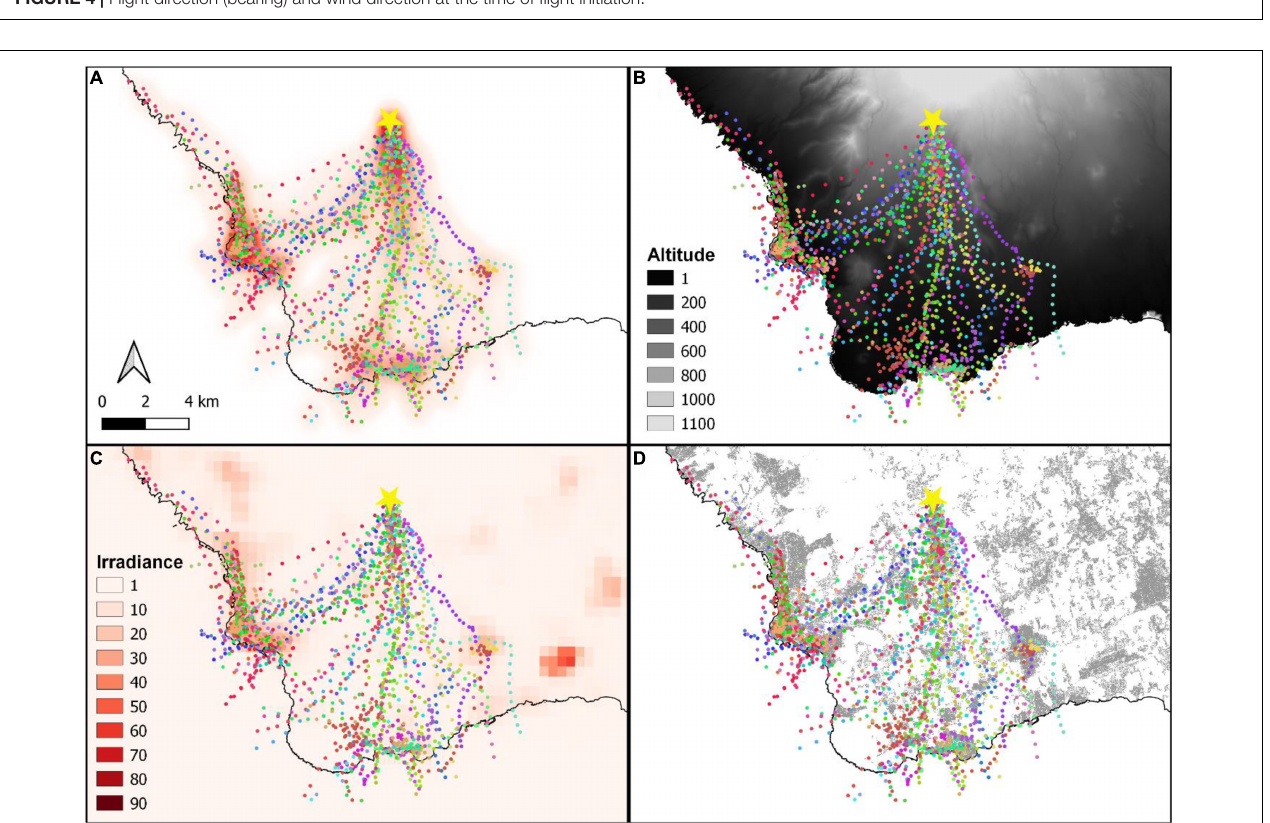
FIGURE 5 | GPS locations of Cory’s shearwater Calonectris borealis fledglings tracked in the south of Tenerife, Canary Islands, during the fledging seasons of 2017–2019. (A) Heat map of all GPS locations. (B) Digital elevation model. (C) Irradiance levels taken as a proxy of light pollution from a monthly composite of November 2019 VIIRS. (D) Urban areas are depicted in grey. Yellow star indicates the release